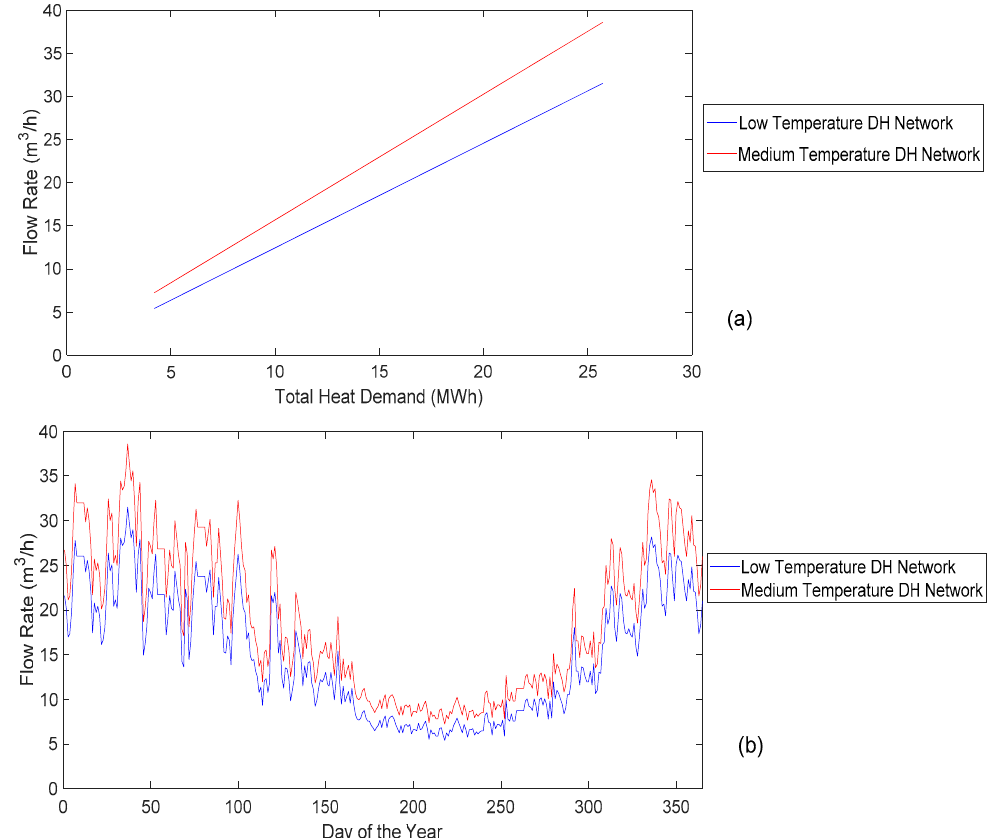
Figure 4. ( a ) Flow rate of medium and low temperature DH networks as function of thermal demand. ( b ) Flow rate for mean and low temperature DH networks along the year.